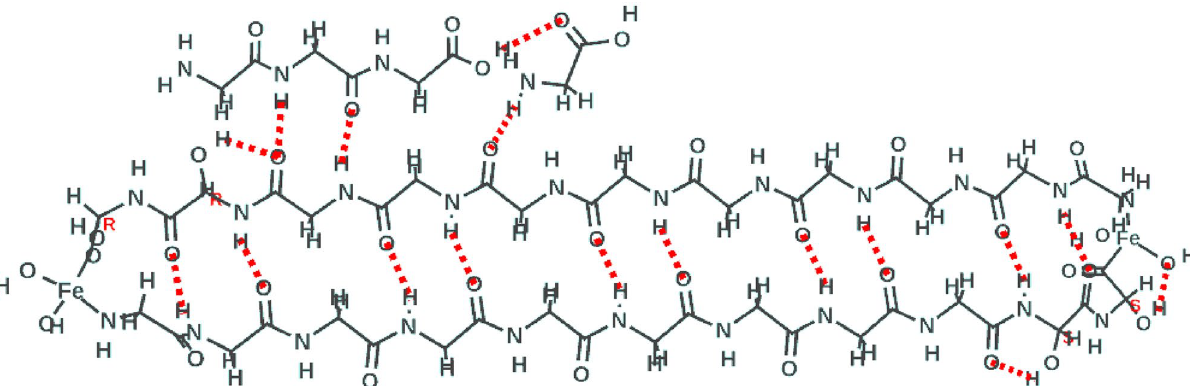
Figure 7. Cartoon of “core” replication process. Line molecular format. A peptide of 4 glycine units has started a replication and aligned to the core with a single glycine coming in to form an amide bond to make a 5-mer glycine. Hydrogen bonds in red. R/S labeling denotes chirality of hydroxy-glycine units. Spartan ’20 Version 1.1.5 (220607) (Mac OS